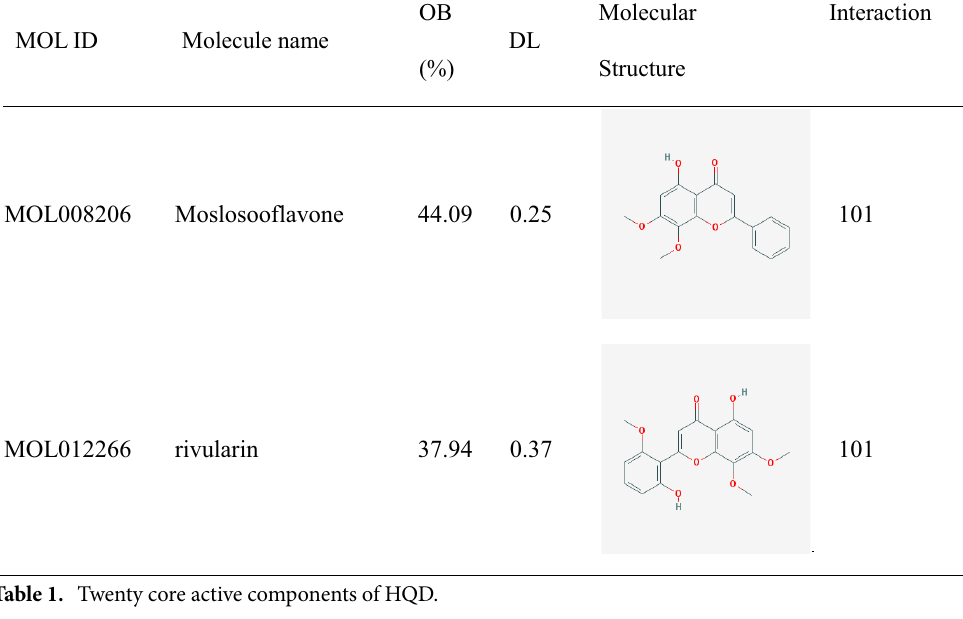
Table 1. Twenty core active components of